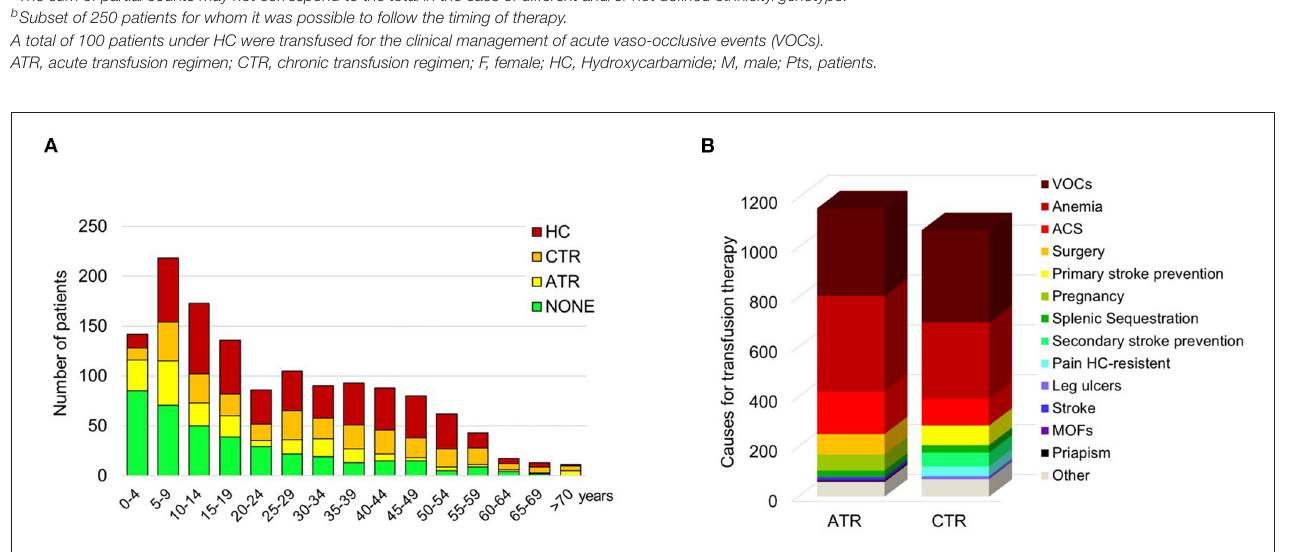
FIGURE 2 | (A) Distribution of sickle cell disease (SCD) patients by age and therapy. Data are shown as a column chart that reports, for each age group, the number of patients that received HC/ATR/CTR/NONE as their therapy regimen. (B) Distribution of the indications for transfusion therapy. Data are shown as counts of the indications for ATR and CTR. ACS, acute chest syndrome; ATR, acute transfusion; CTR, chronic transfusion; HC, hydroxycarbamide; MOFs, multi-organ failures; VOCs, vaso-occlusive